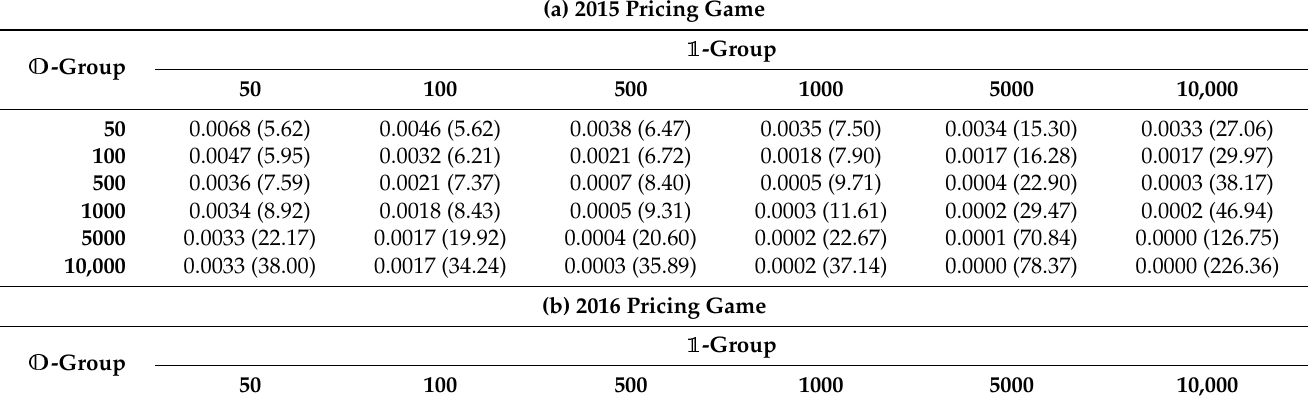
( 0.05 ) on the 0,1 +